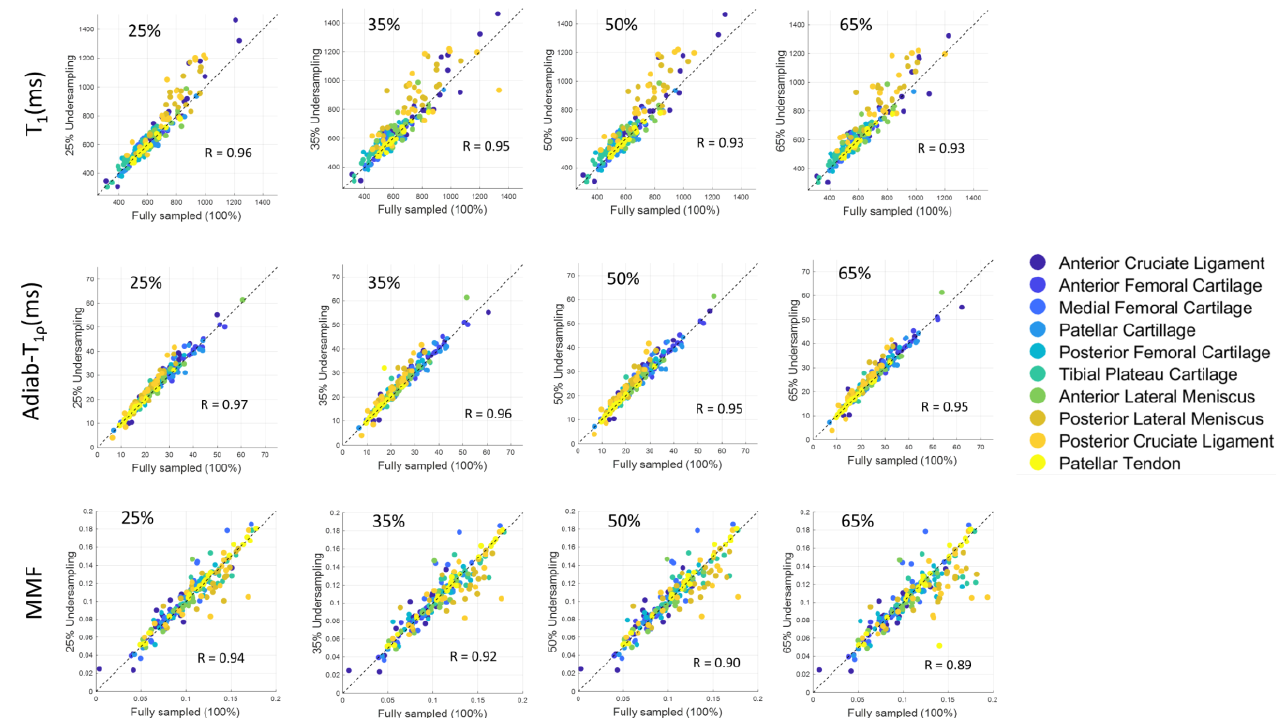
Figure 8. Scatter plot for various quantification parameters (i.e., T 1 , T 1ρ , and MMF) at different undersampling levels in ROIs from human knee joint. Correlation coefficient (R) recorded over 0.85 for all parameters in all four undersampling rates. While very few points can be recognized as outliers, parameters estimated in most of the ROIs showed high linearity between undersampled CS reconstruction and fully sampled reconstruction.